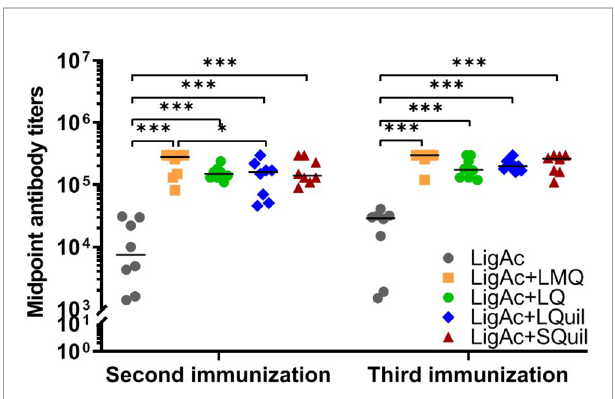
FIGURE 2 | Comparison of LigAc-speci fi c IgG titers among vaccine formulations. The antibody titers in the vaccinated hamsters at 1 week after the second and the third immunization were measured by ELISA. Mann – Whitney U test was used to compare antibody titers between groups; * represents p < 0.05. and *** represents p < 0.001.